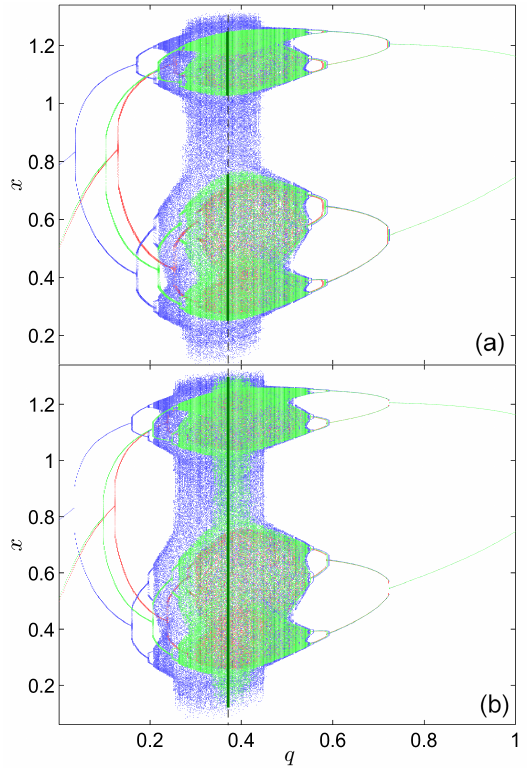
Figure 6. The BDs of system (8) for p = 0.55, obtained with the same three different initial conditions but with different maximum iteration numbers: ( a ) 3500 iterations; ( b ) 5000